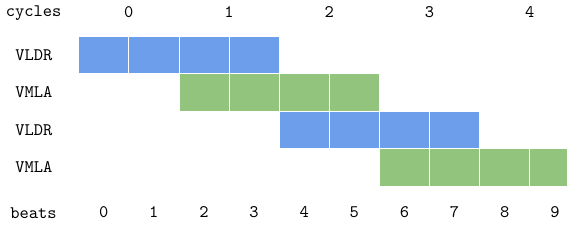
Figure 2 Instruction overlapping on a dual-beat implementation of